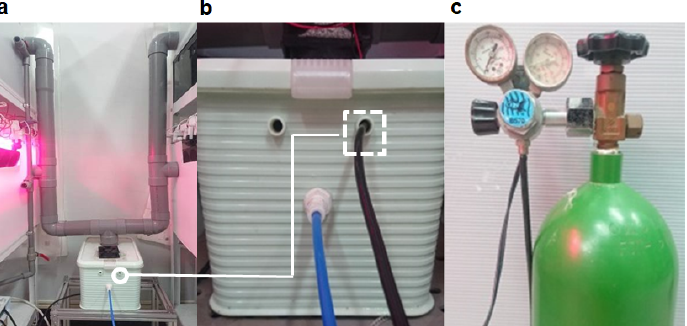
Figure 5. Mist generation system and CO 2 generator. ( a ) The generation pipeline and mist genera- tion tank; ( b ) reverse osmosis (RO) water delivery hose (blue colour) and CO 2 gas input hole (white coloured frame); ( c ) CO 2 cylinder and a double-header pressure reducer. Double-header pressure reducer is located to the left of the cylinder on the image. The gauges on the right and left show the pressure in the cylinder and the pressure at the outlet, respectively.